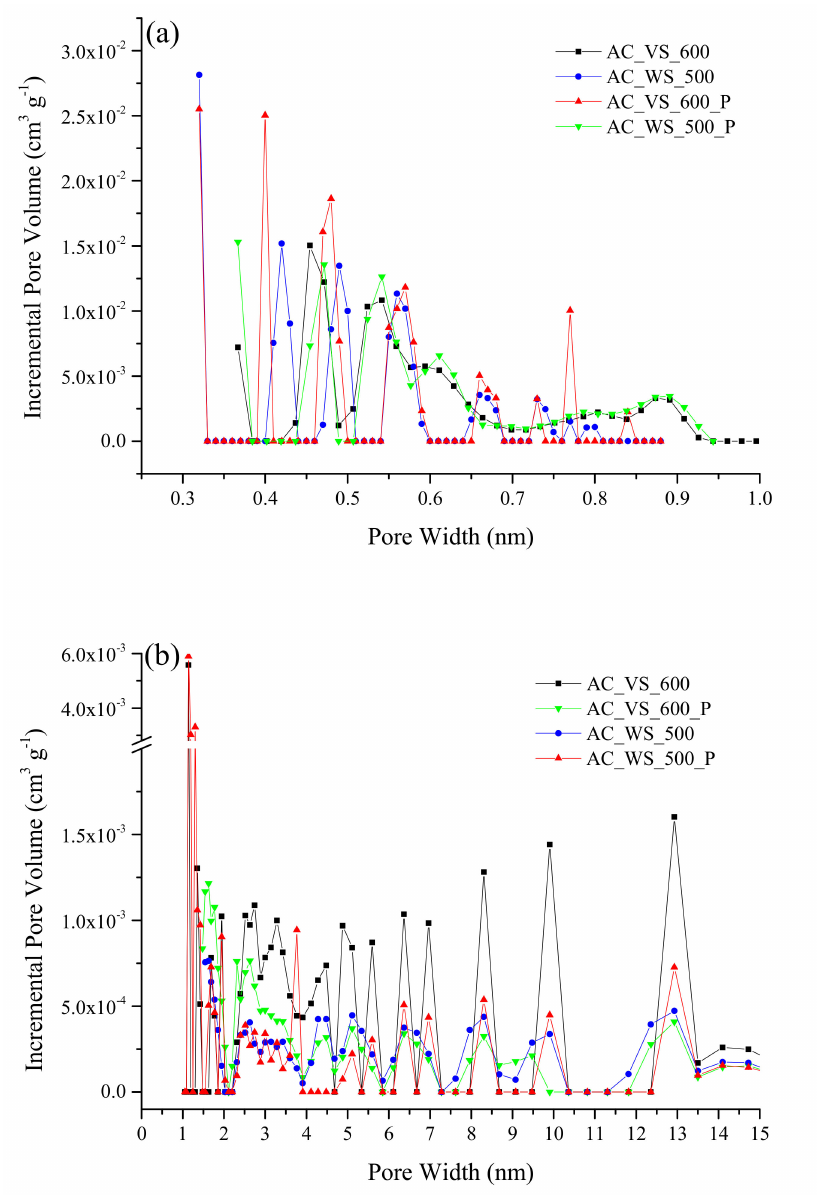
Figure 4. Pore size distribution of the adsorbents: ( a ) narrow micropores (deduced from the CO 2 adsorption isotherms at 0 ◦ C), and ( b ) pores widths ranging from 1.0 to 15 nm (deduced from the N 2 adsorption isotherms at − 196 ◦